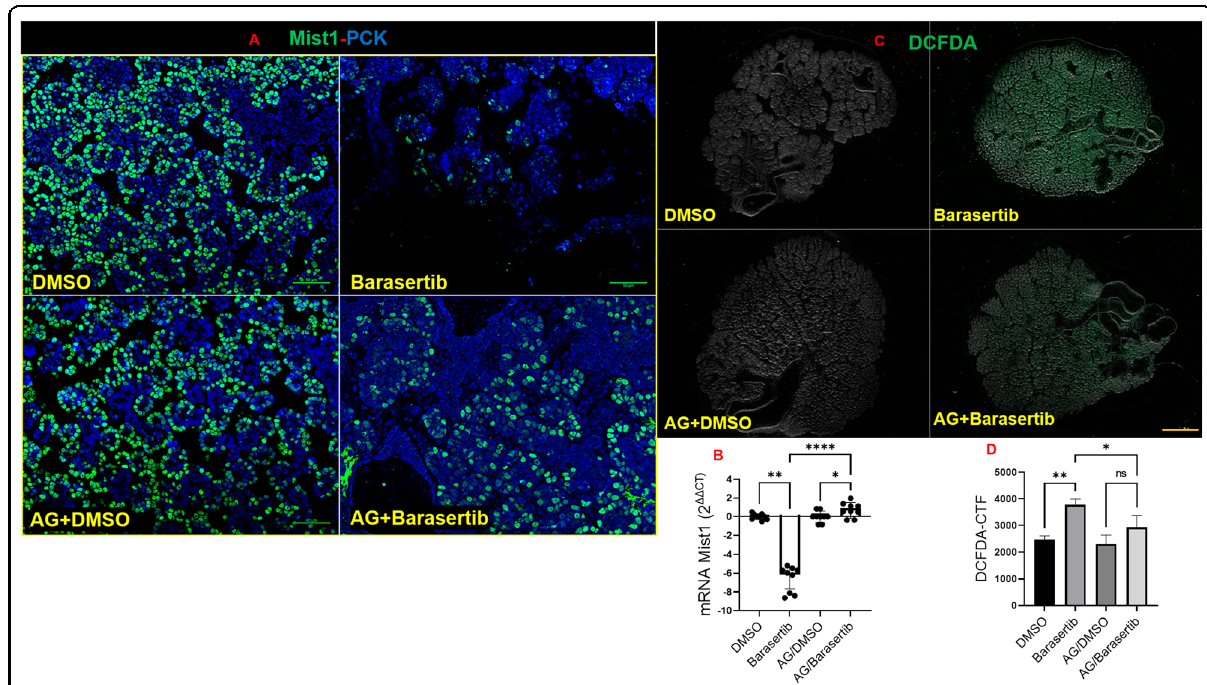
Fig. 8 AURKB loss disrupted acinar identity via ROS generation. A , B Mist1 (green) and pan cytokeratin (blue) expressions in E16.5 + 24h bud cells, scale bar = 50 µm. Remarkable loss of the acinar differentiation marker Mist1 at the protein and transcriptional levels in response to Barasertib treatment. Recovery of Mist1 levels due to ROS scavenging using aminoguanidine (number of pooled glands ≥ 5), analysed by ANOVA ** P ≤ 0.01, * p ≤ 0.05, **** P ≤ 0.0001. C , D ROS production in response to AURKB inhibition in the embryonic salivary glands. ROS levels were visualised in the SMG explants after staining with DCFDA and inspection under fl uorescence microscope. Analysis of corrected total fl uorescence (CTF) using ImageJ revealed that Barasertib treatment for 24 h signi fi cantly increased levels of ROS in the E16.5 + 24h explants which were signi fi cantly reduced after co- treating the explants with aminoguanidine, analysed by ANOVA, ** P ≤ 0.01, * p ≤ 0.05, ns: non-signi fi cant, p > 0.05. Scale bar = 500 μ m, n =